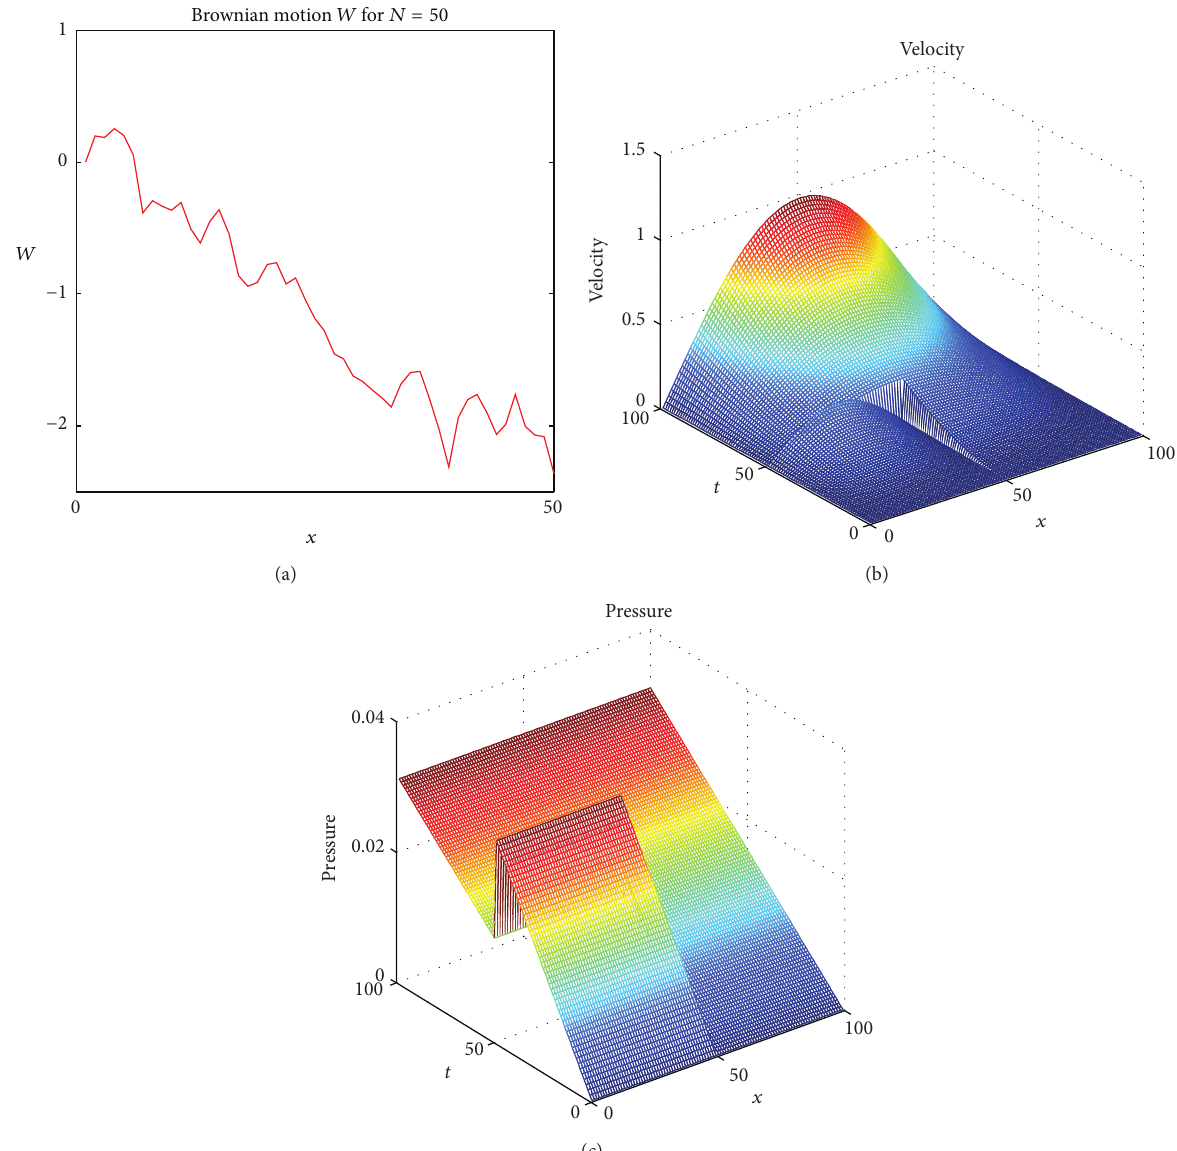
Figure 2: The Brownian, the associated velocity and pressure, and instable